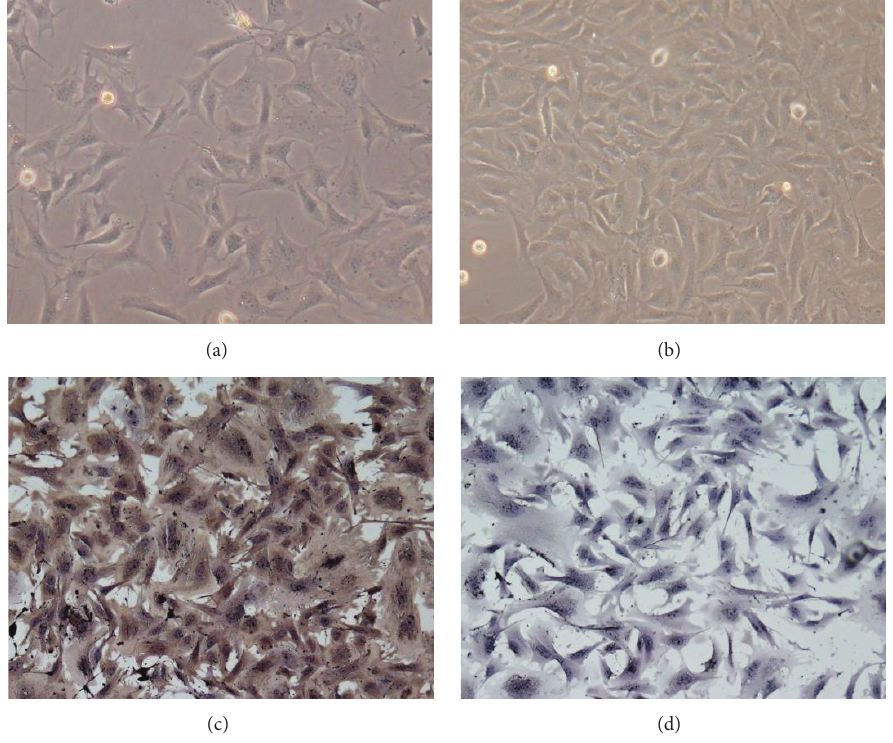
Figure 1: (a) Phase-contrast microscopy of BRPCs at five days after isolation, with irregular peripheries × 100. (b) Phase-contrast microscopy of BRPCs at 10 days after isolation, with non-contact-inhibited and overlapping pattern of growth × 100. (c) Positive staining of pericytes with anti- 𝛼 isoforms of smooth-muscle actin (DAB × 200). (d) Negative staining of pericytes with anti-von Willebrand factor (DAB ×